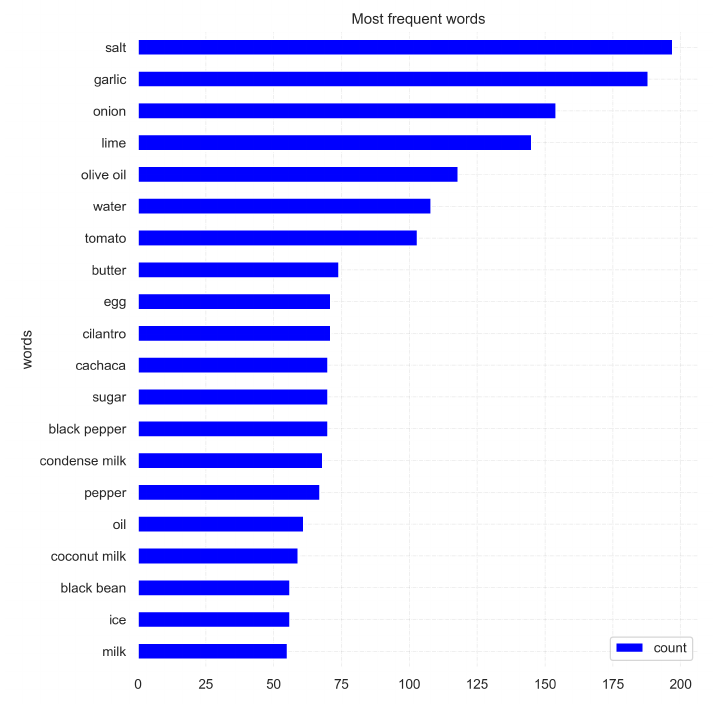
Figure 2. Top 20 ingredients for the Brazilian cuisine